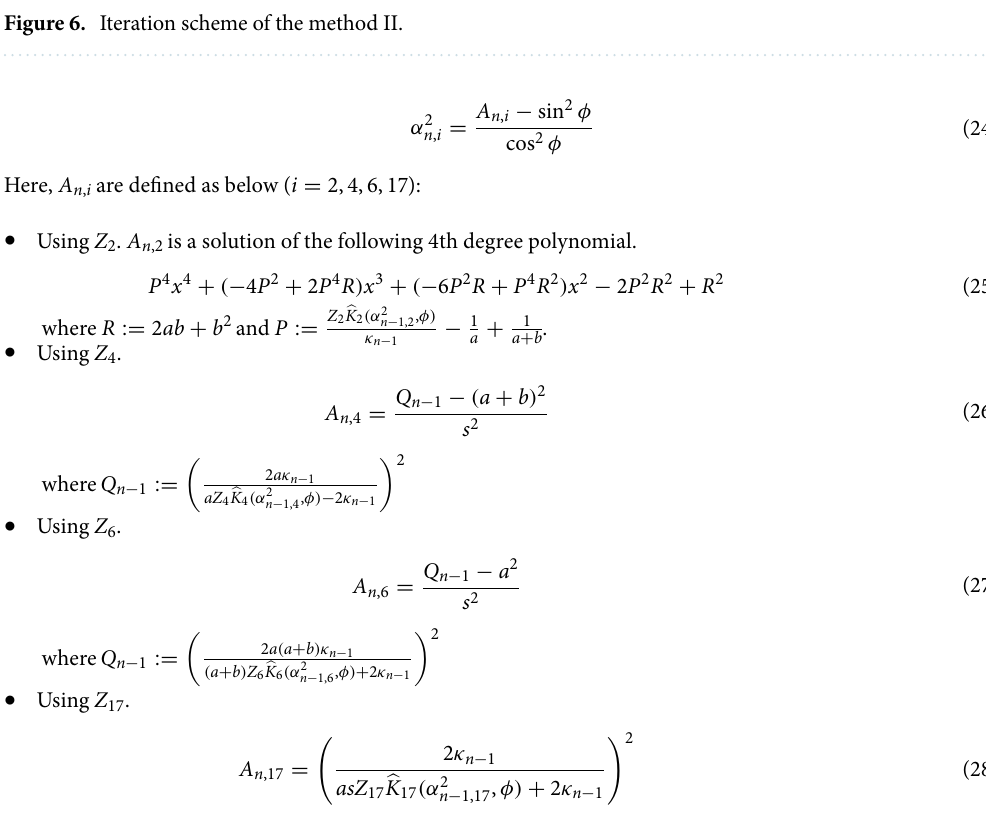
Figure 6. Iteration scheme of the method